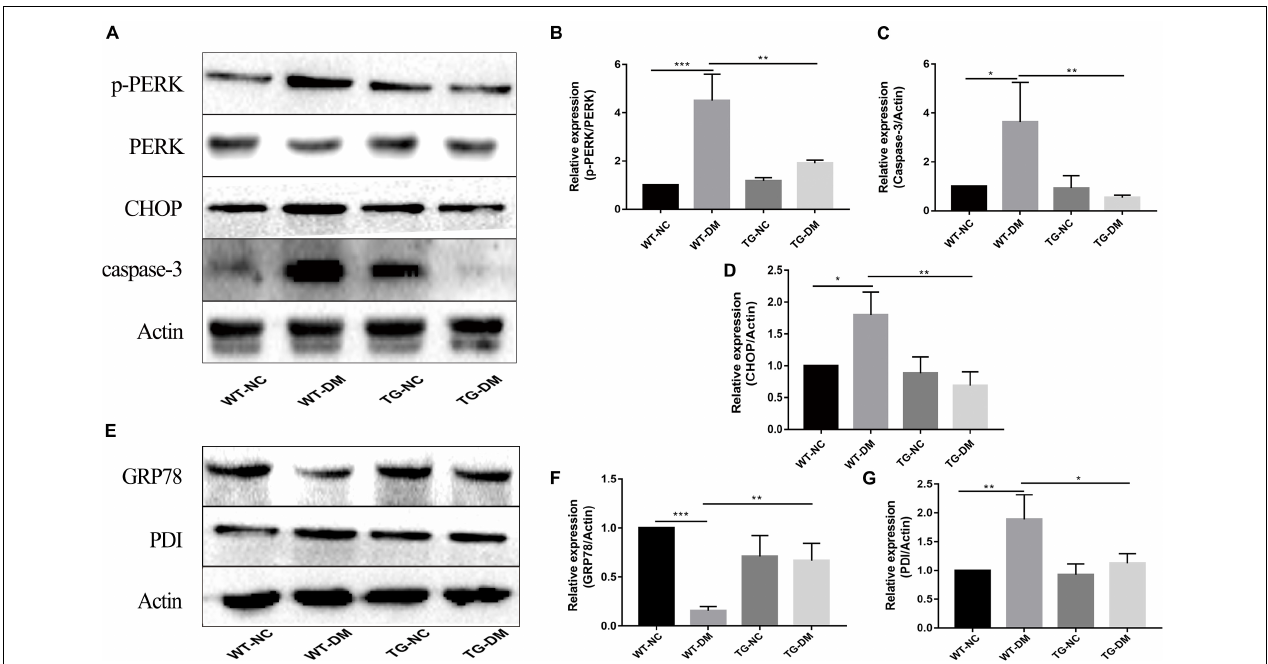
FIGURE 4 | Effects of DM and Trx-1 on the protein immunocontent of GRP78 and PDI and changes in the activation of PERK, CHOP and caspase-3 in the PERK receptor-related signaling pathway in DM mice. (A) Representative protein expression bands of PERK, p-PERK, CHOP and caspase-3. (B) Representative Western blot analysis of p-PERK/PERK. (C) Representative Western blot analysis of caspase-3. (D) Representative Western blot analysis of CHOP. (E) Representative protein expression bands of GRP78 and PDI. (F) Representative Western blot analysis of GRP78. (G) Representative Western blot analysis of PDI. Tukey’s post hoc test for one-way ANOVA was used to analyze the Western blot immunocontent. For each group, n = 6. The vertical lines represent the standard error of the mean. * p < 0.05, ** p < 0.01, and *** p <